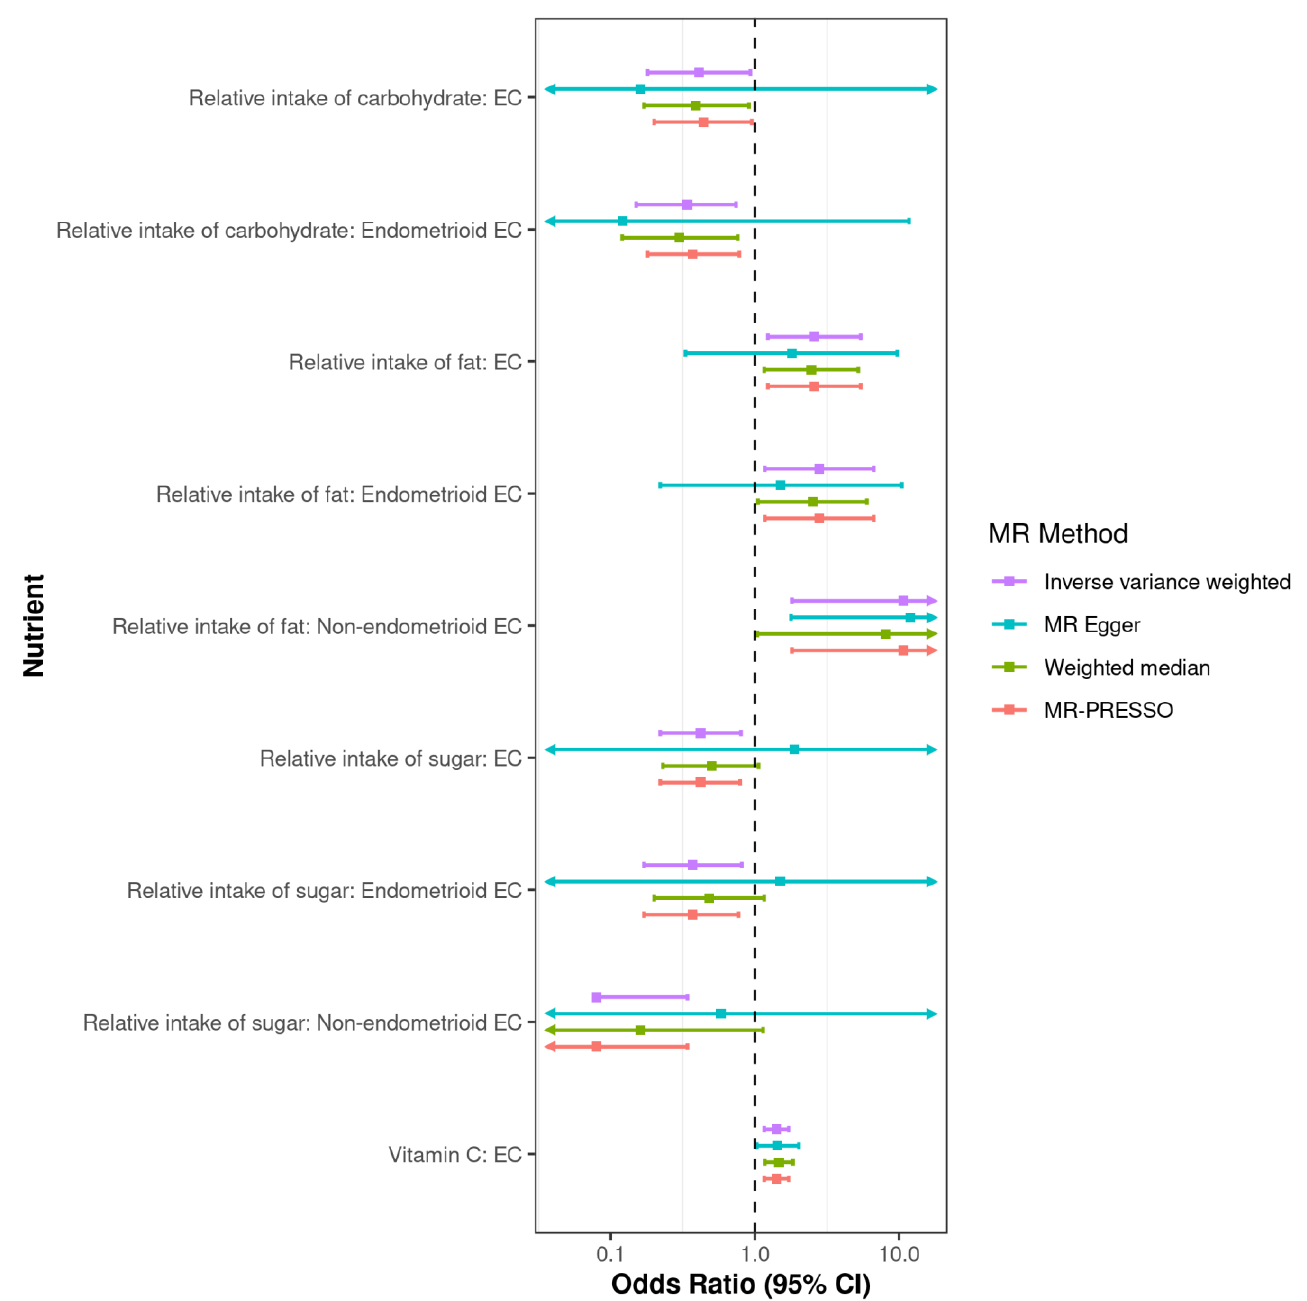
Figure 1. Plot of MR sensitivity analyses for dietary that were associated with endometrial cancer (EC) risk by the primary IVW